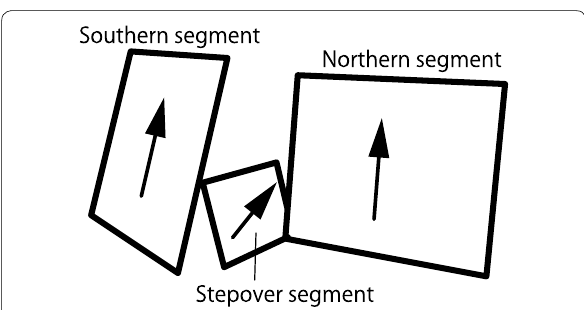
Fig. 5 A schematic illustration of a fault model ruptured by the 2018 Hokkaido Eastern Iburi earthquake. The view point is located northeast of the focal area. Arrows indicate the motion of the hanging wall of individual